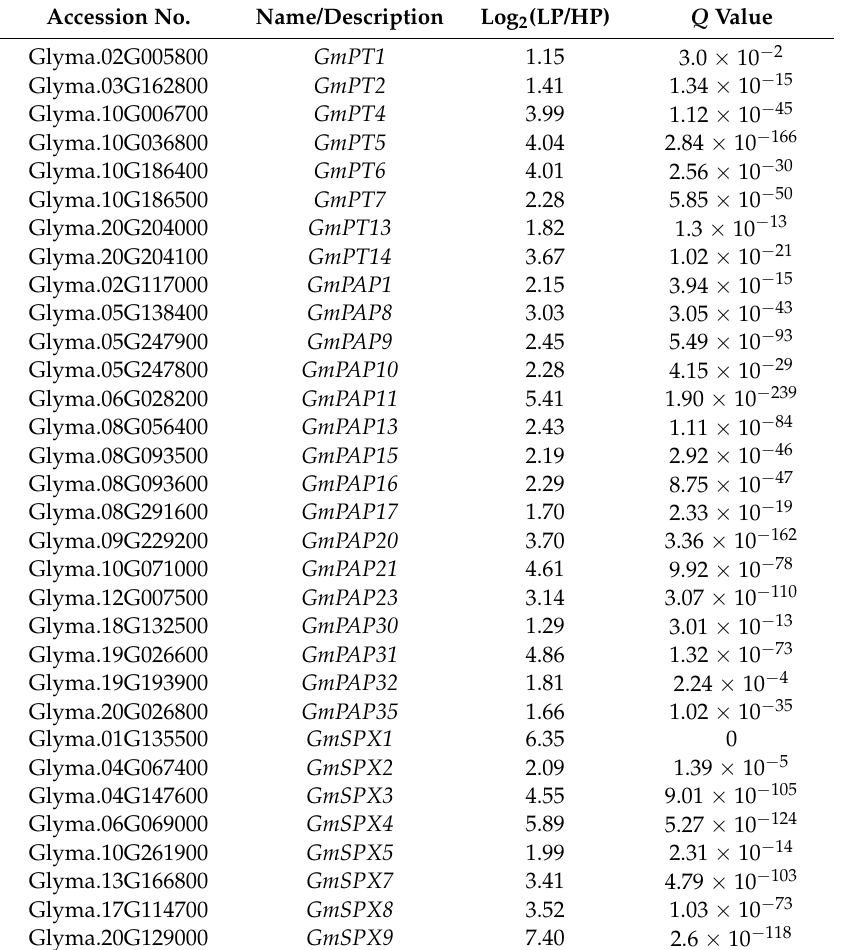
Table 3. Differentially expressed genes involved in Pi